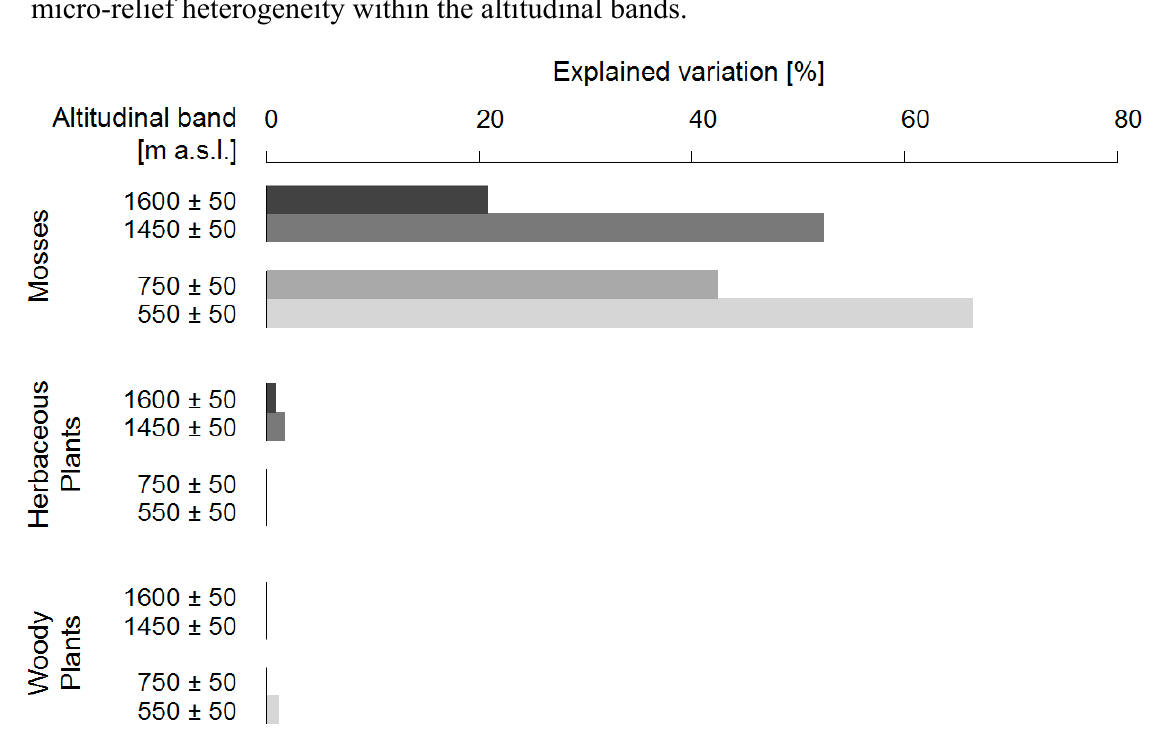
Figure 6. Explained variation of species richness in percent (divided into mosses, herbaceous plants, woody plants and total species richness) by the explanatory variable micro-relief heterogeneity within the altitudinal